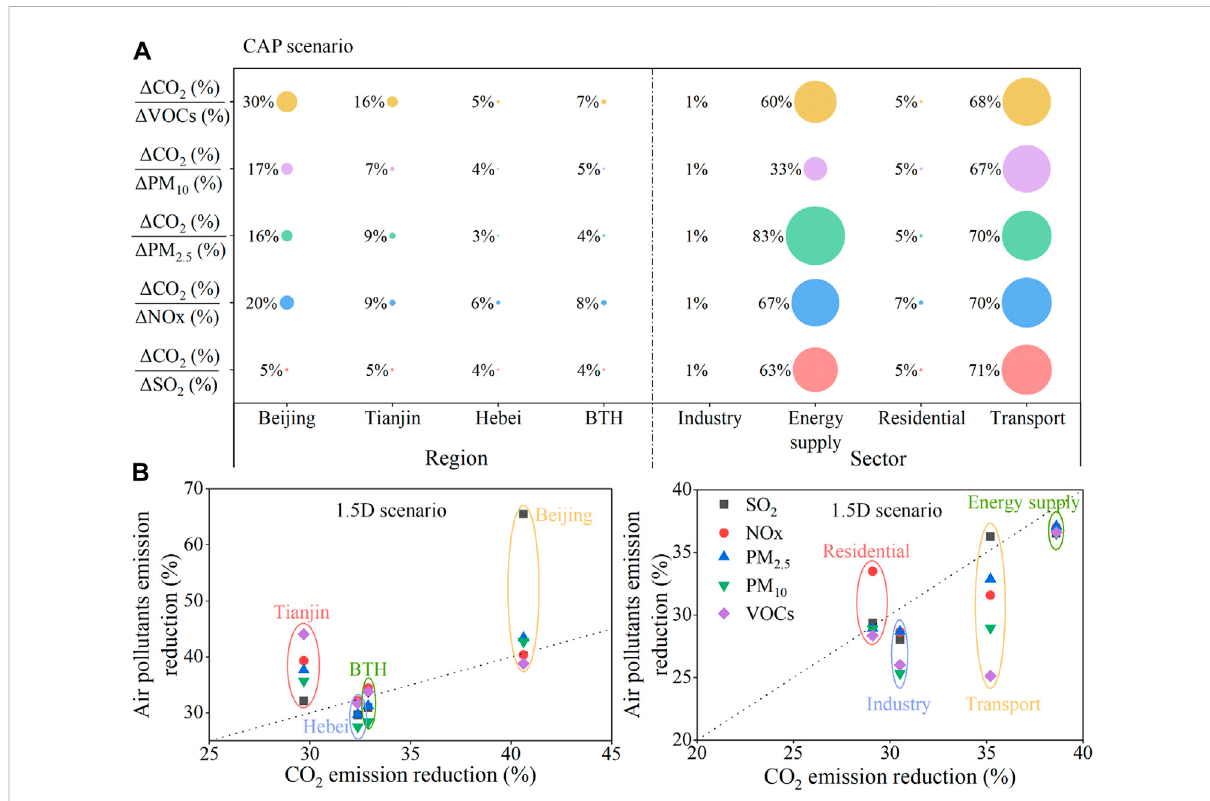
FIGURE 6 ThevalueofCO 2 emissionreductiontoairpollutantchangeinCAPscenariocomparedwithREFfromtheregionandsectorperspectives (A) ,air pollutants emission and CO 2 emission change compared with REF in 2030 from the region and sector perspectives (B)